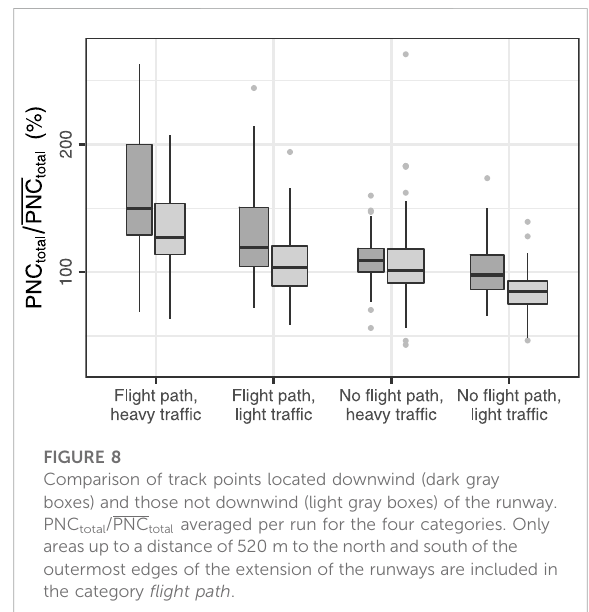
FIGURE 7 PNC total /PNC total averaged per run for four categories. Black dotsindicatethearithmeticmeanoverallrunswithinthecategory. Only areas up to a distance of 520 m distance to the north and southoftheoutermostedgesoftheextensionoftherunways are included in the category fl ight path .